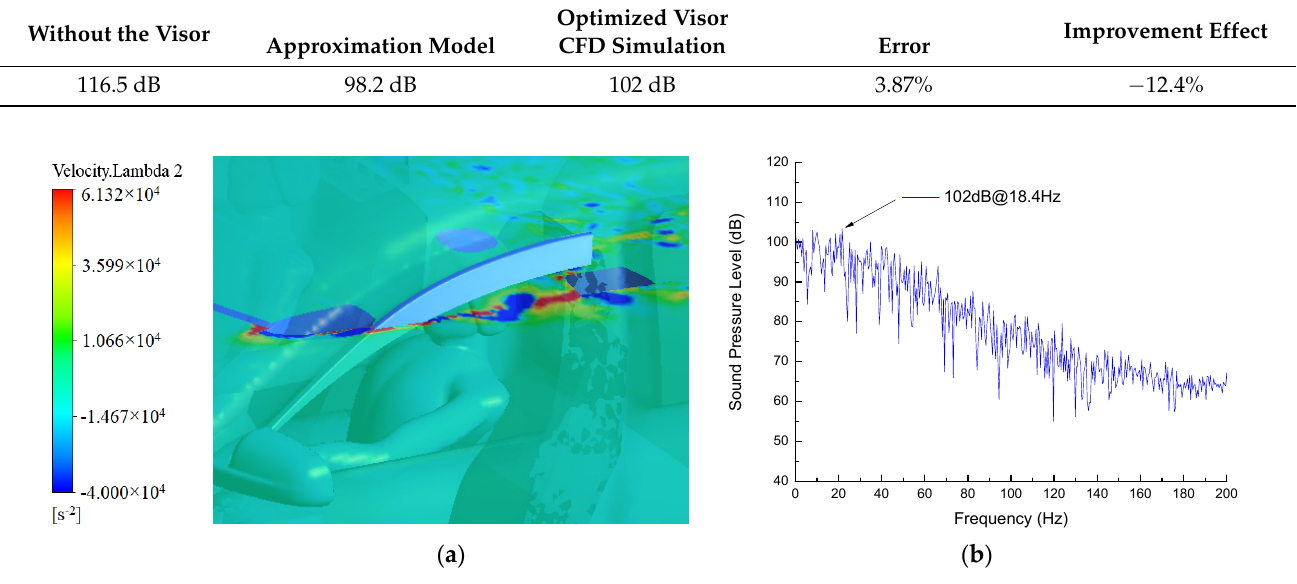
Table 4. Comparison of optimization results.